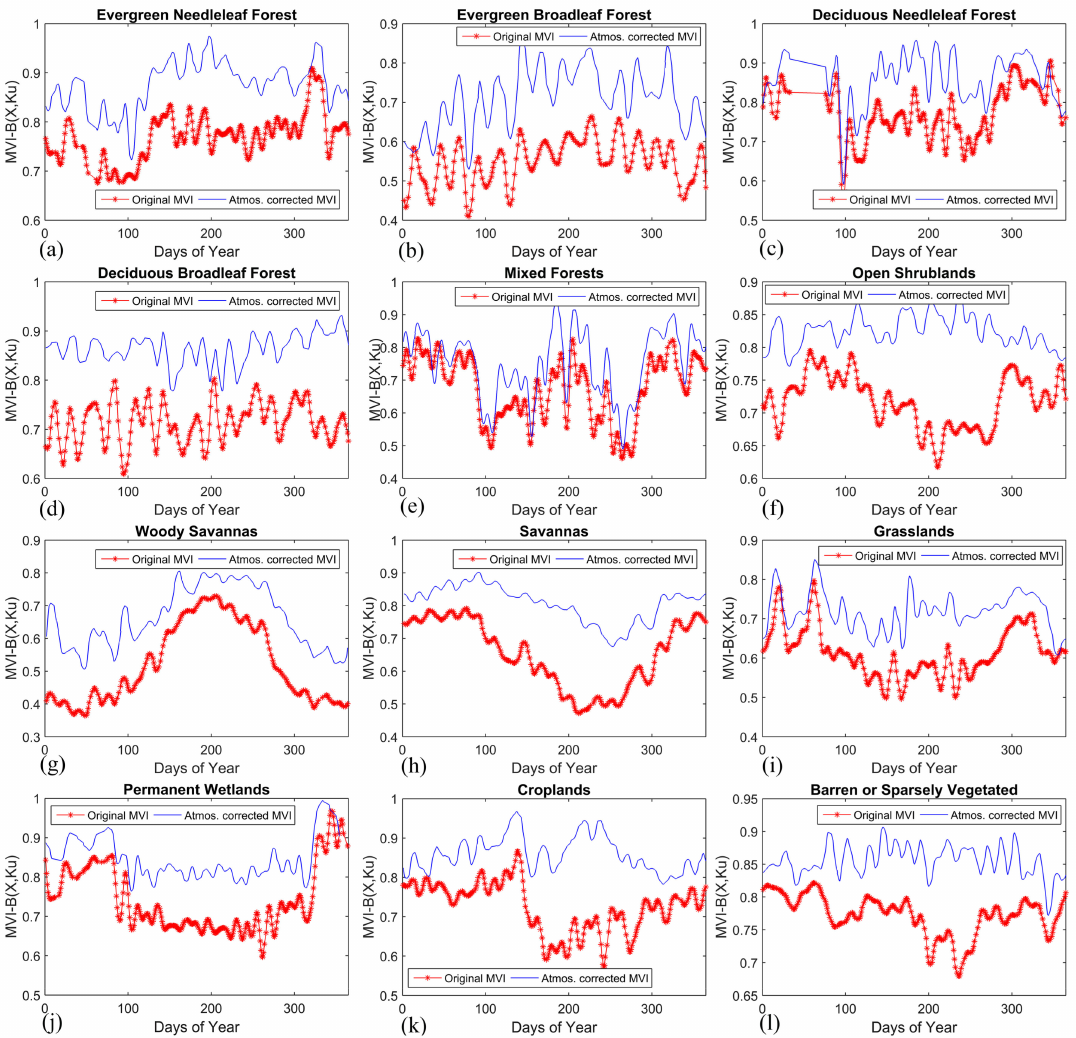
Figure 7. Time series comparison between MVI _ B ( X , Ku ) ∗ [original microwave vegetation index (MVI)] and MVI _ B ( X , Ku ) (atmosphere corrected MVI) on various land surface types. ( a ) Time series comparison between MVI _ B ( X , Ku ) ∗ and MVI _ B ( X , Ku ) on Evergreen Needleleaf Forest; ( b ) Time series comparison between MVI _ B ( X , Ku ) ∗ and MVI _ B ( X , Ku ) on Evergreen Broadleaf Forest; ( c ) Time series comparison between MVI _ B ( X , Ku ) ∗ and MVI _ B ( X , Ku ) on Deciduous Needleleaf Forest; ( d ) Time series comparison between MVI _ B ( X , Ku ) ∗ and MVI _ B ( X , Ku ) on Deciduous Broadleaf Forest; ( e ) Time series comparison between MVI _ B ( X , Ku ) ∗ and MVI _ B ( X , Ku ) on Mixed Forest; ( f ) Time series comparison between MVI _ B ( X , Ku ) ∗ and MVI _ B ( X , Ku ) on Open Shrublands; ( g ) Time series comparison between MVI _ B ( X , Ku ) ∗ and MVI _ B ( X , Ku ) on Woody Savannas; ( h ) Time series comparison between MVI _ B ( X , Ku ) ∗ and MVI _ B ( X , Ku ) on Savannas; ( i ) Time series comparison between MVI _ B ( X , Ku ) ∗ and MVI _ B ( X , Ku ) on Grasslands; ( j ) Time series comparison between MVI _ B ( X , Ku ) ∗ and MVI _ B ( X , Ku ) on Permanent Wetlands; ( k ) Time series comparison between MVI _ B ( X , Ku ) ∗ and MVI _ B ( X , Ku ) on Croplands; ( l ) Time series comparison between MVI _ B ( X , Ku ) ∗ and MVI _ B ( X , Ku ) on Barren or Sparsely